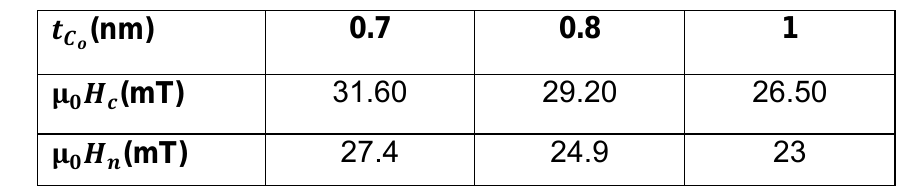
Table 1. Data obtained from the quasi-static